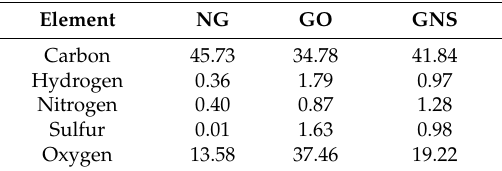
Table 1. Elemental analysis of samples (% ms).